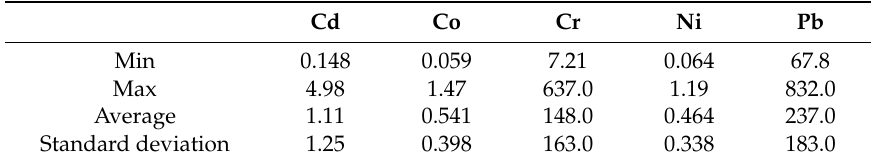
Table 4. Values of sorption distribution coefficient K d (in L/g) obtained from the batch sorption tests. Cd Co Cr Ni Pb Min 0.148